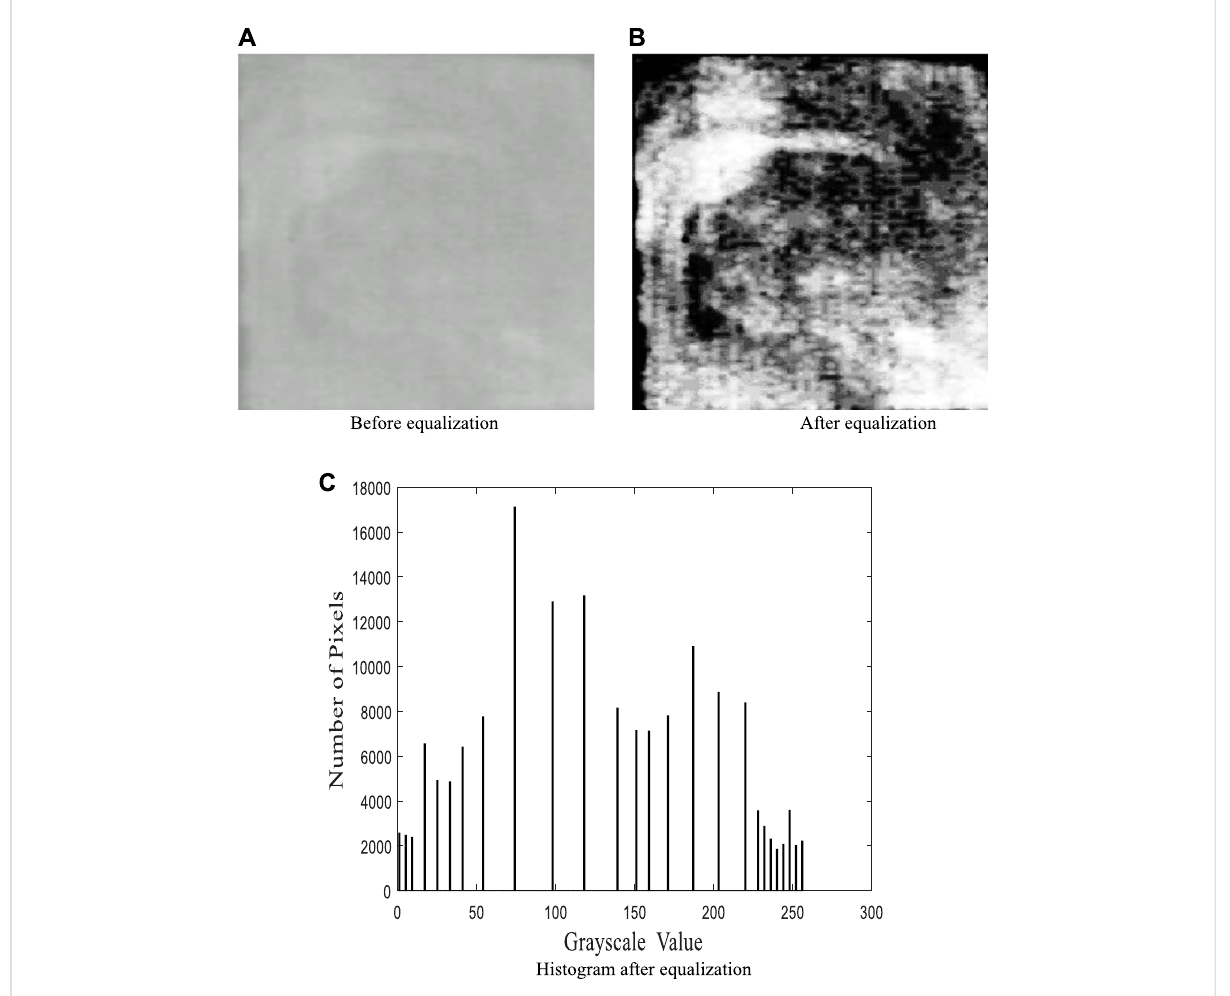
FIGURE 5 Image histogram equalization. (A) Before equalization (B) After equalization (C) Histogram after